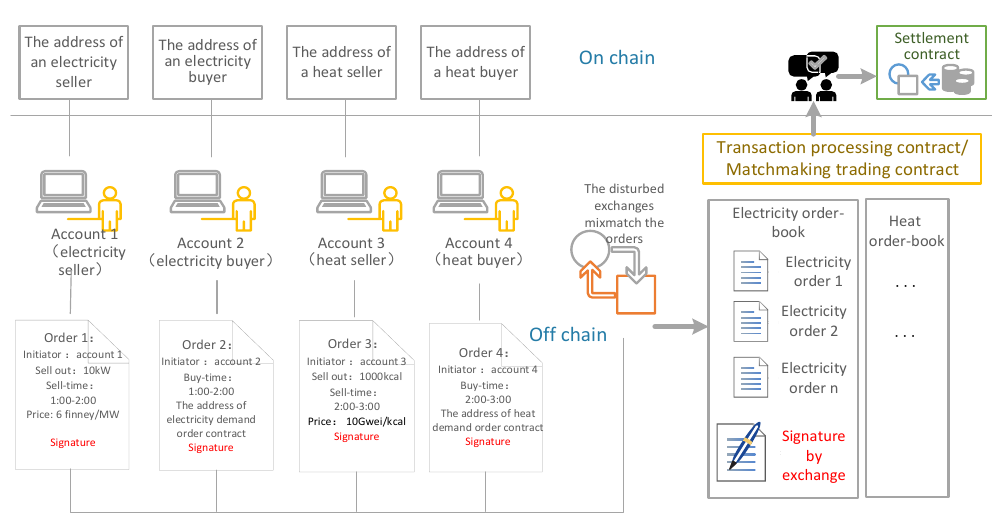
Figure 1. Process diagram of the transactions.